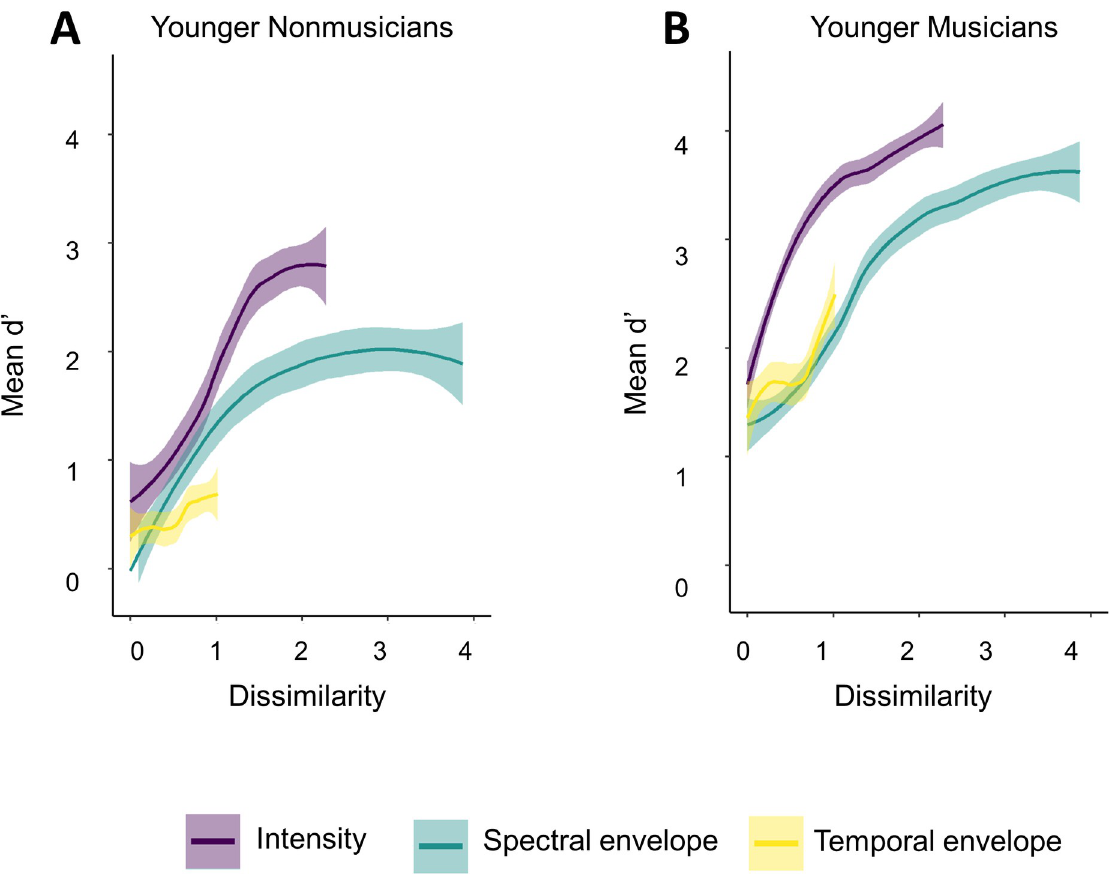
Fig 5. Mean d’ plotted on a common perceptual scale, younger adults. Performance plotted against dissimilarity, allowing features to be directly compared for younger adults: non-musicians (A) and musicians (B). Standard errors are shown by grey shading around each